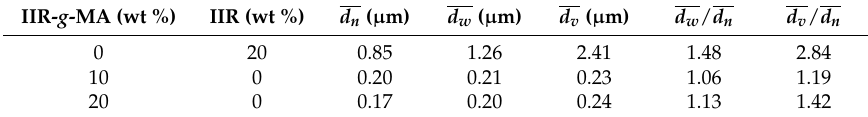
Table 2. Rubber particle size comparison for binary PA-6/IIR- g -MA and PA-6/IIR blends.